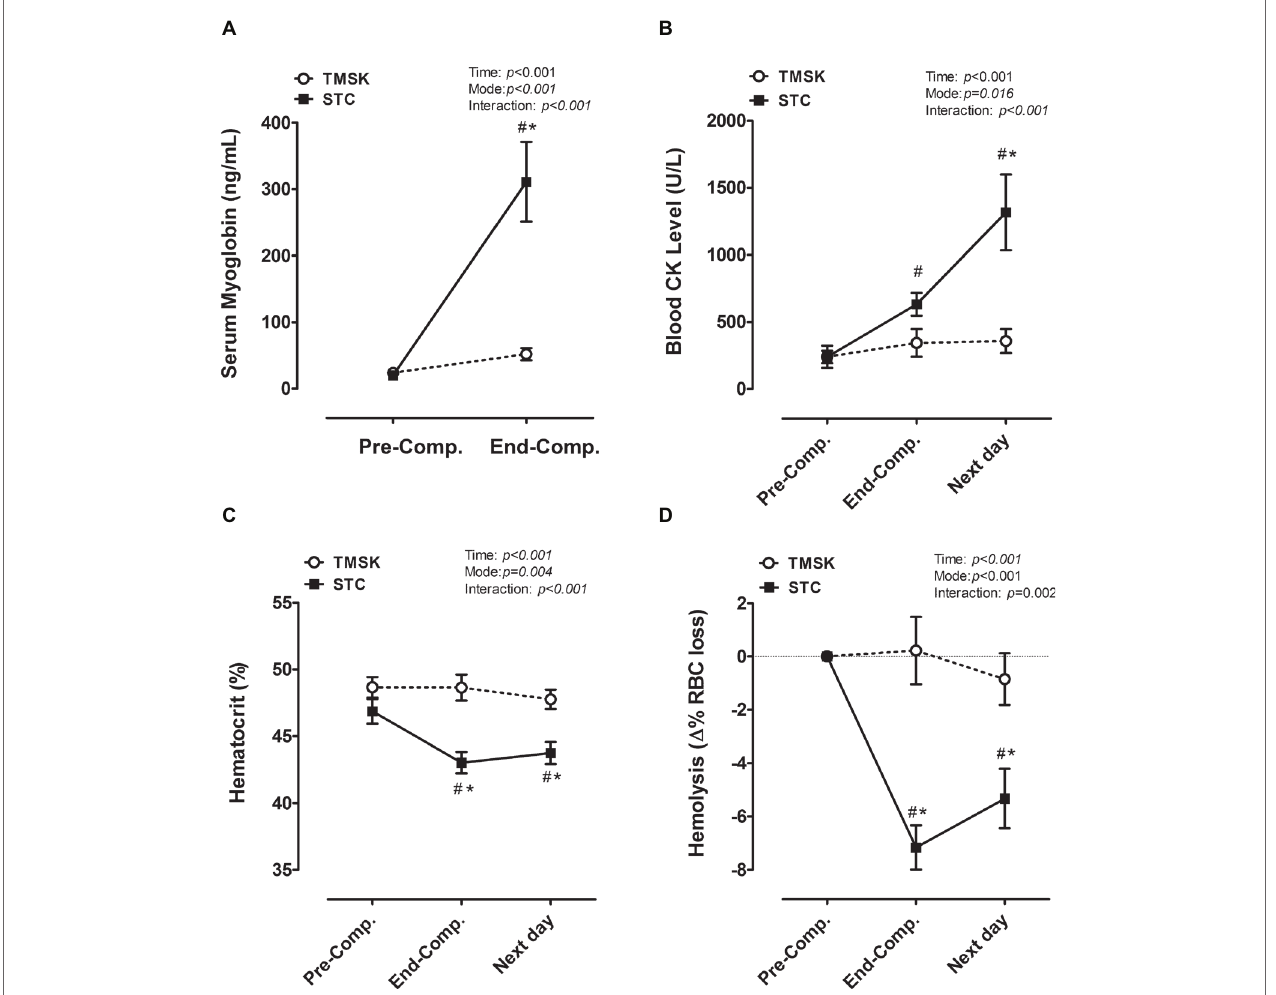
FIGURE 3 | The responses of muscle-damaging blood biomarkers and status of hemolysis during real combat match and simulation kicking exercise. (A) Serum myoglobin, (B) blood CK, (C) hematocrit, (D) hemolysis. # denotes the significant difference compared to baseline values ( p < 0.05); * denotes a significant difference between TMSK and STC ( p < 0.05). TMSK: TKD-match simulated kicks; STC: simulated TKD